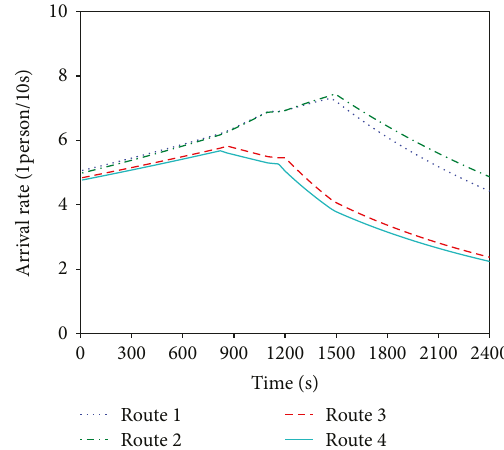
Figure 6: The relationship between departure time choice and travel route choice.